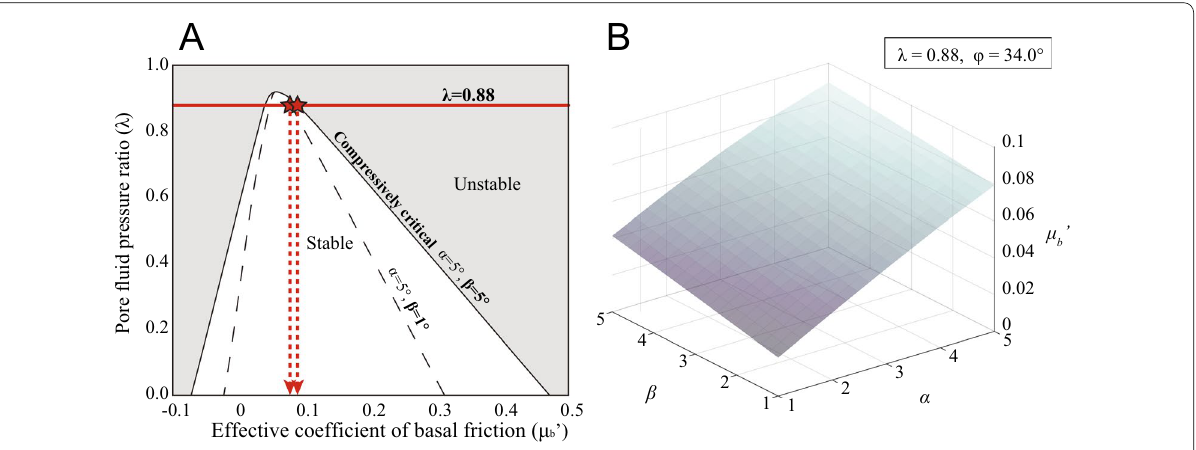
Fig. 3 Considering the weight of basal dip angle β . A Mechanically critical value of a frontal wedge is controlled by the pore fluid pressure ratio within the prism ( λ ) and the effective basal friction ( μ b ’ ). The solid and broken lines represent the critical state curve for different values of β . B Variation in μ b ’ when the slope angle α and the basal dip angle β are varied from 1° to 5°, assuming mean subduction wedge